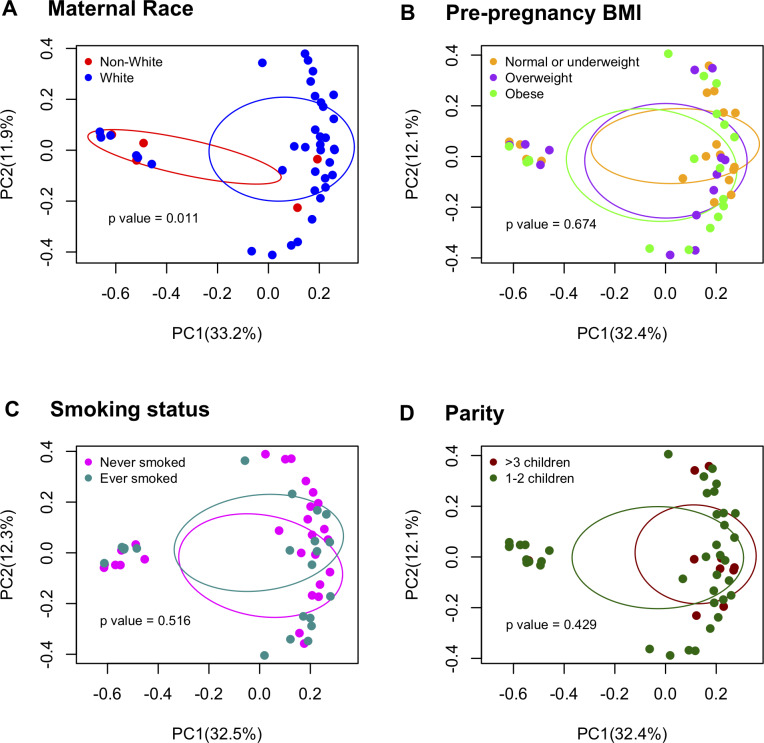
ARG structure by maternal covariates.PCoA plots based on all pregnant (n = 51) samples. Permanova test was calculated to test for differences between groups.